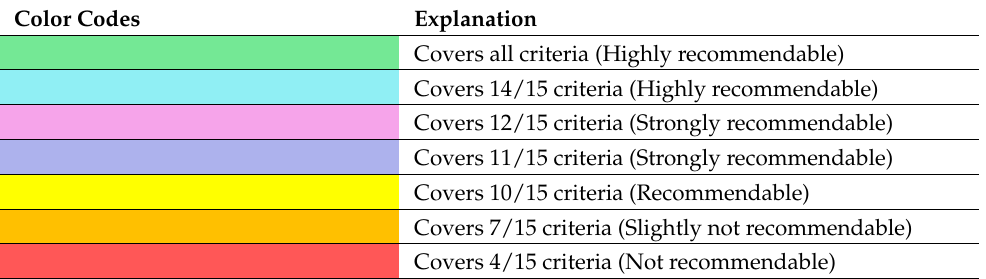
Table 4. Color code